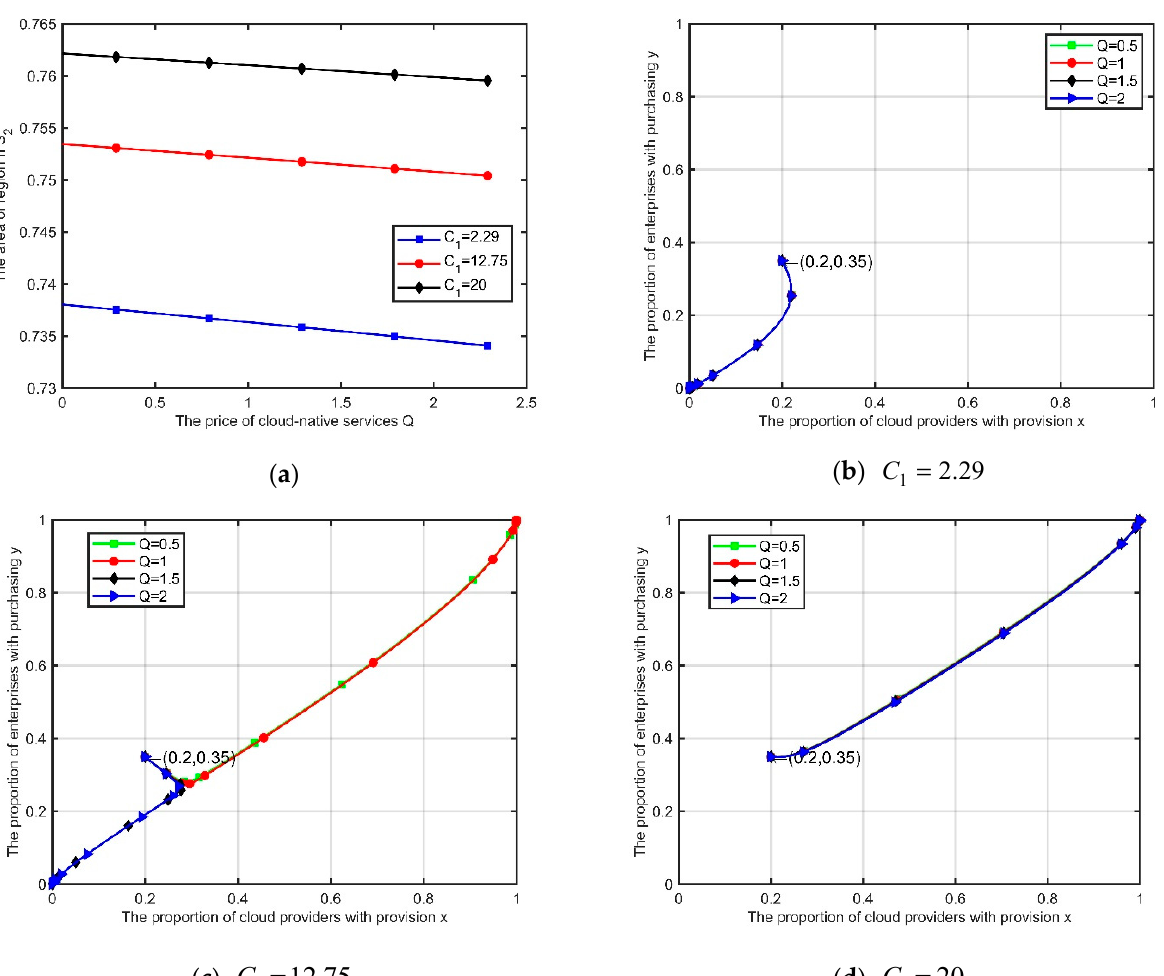
Figure 10. The impact of Q on S II and evolutionary paths ( a ) The impact of Q on S II with different costs C 1 ; ( b ) The evolutionary paths with different prices Q when C 1 = 2.29; ( c ) The evolutionary paths with different prices Q when C 1 = 12.75; ( d ) The evolutionary paths with different prices Q when C 1 = 20